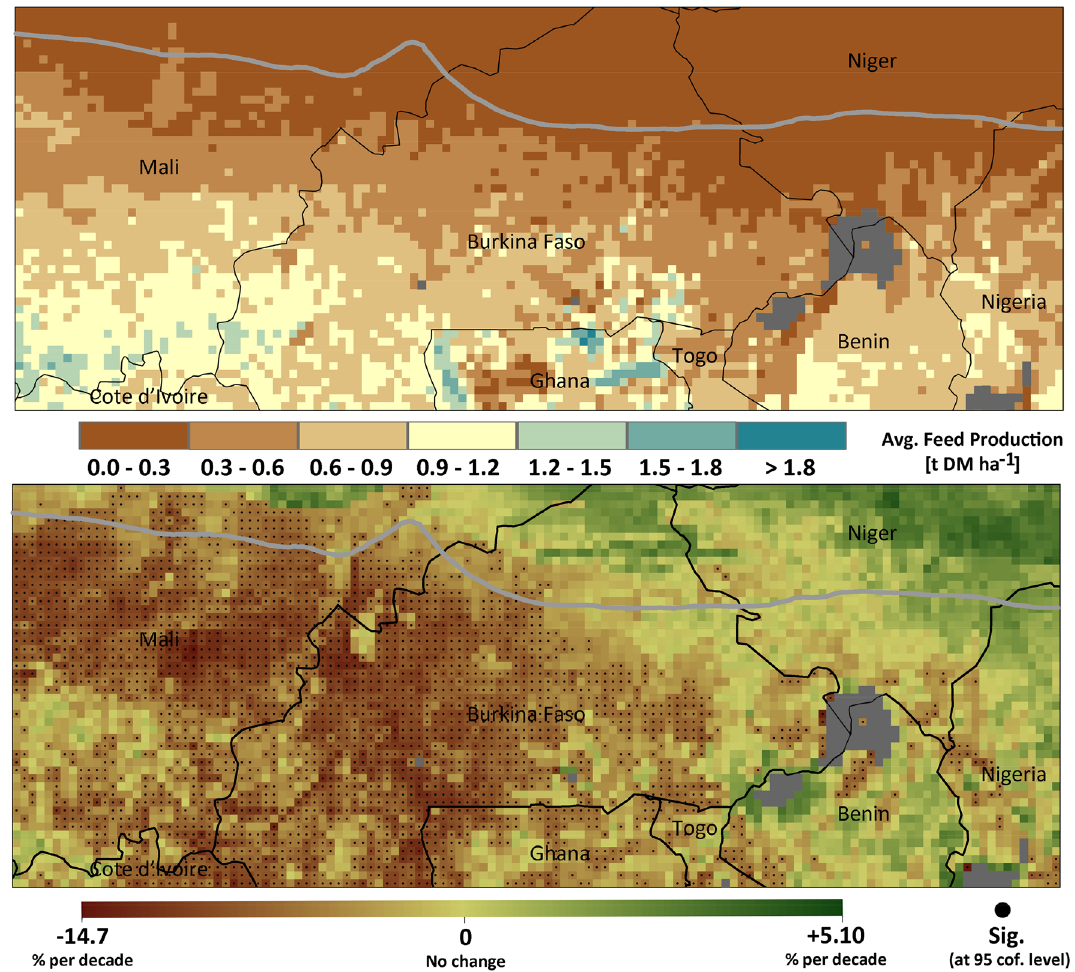
Figure 2. Average feed production and trend in energy supplied from the main feed resources (grass, crop residue, and brows) for livestock during the historical period of 1981 to 2020. Figures were generated using ArcGIS 10.8.1 (https:// www. esri. com/ en- us/ arcgis/ produ cts/ arcgis- pro/ overv